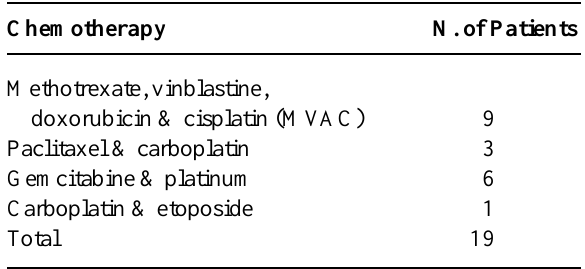
Table 1 – Base-line characteristics of the patients. Table 2 – Distribution of chemotherapy regimens in group-1.